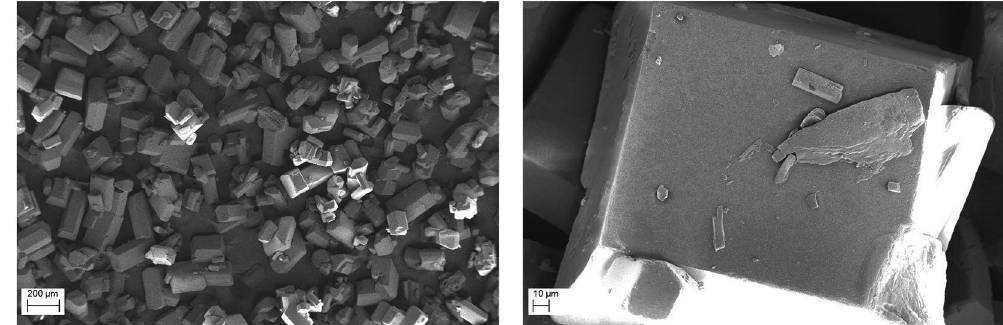
Figure 6. Micrographs of the BTF grains.